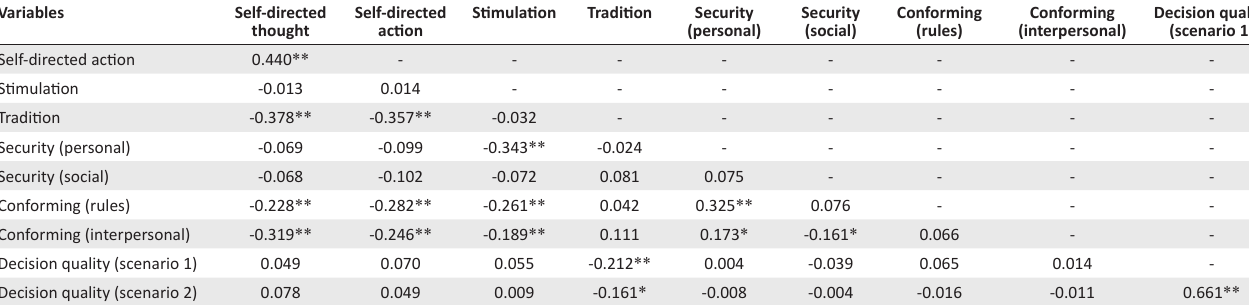
TABLE 2: Pearson’s correlation results. Variables